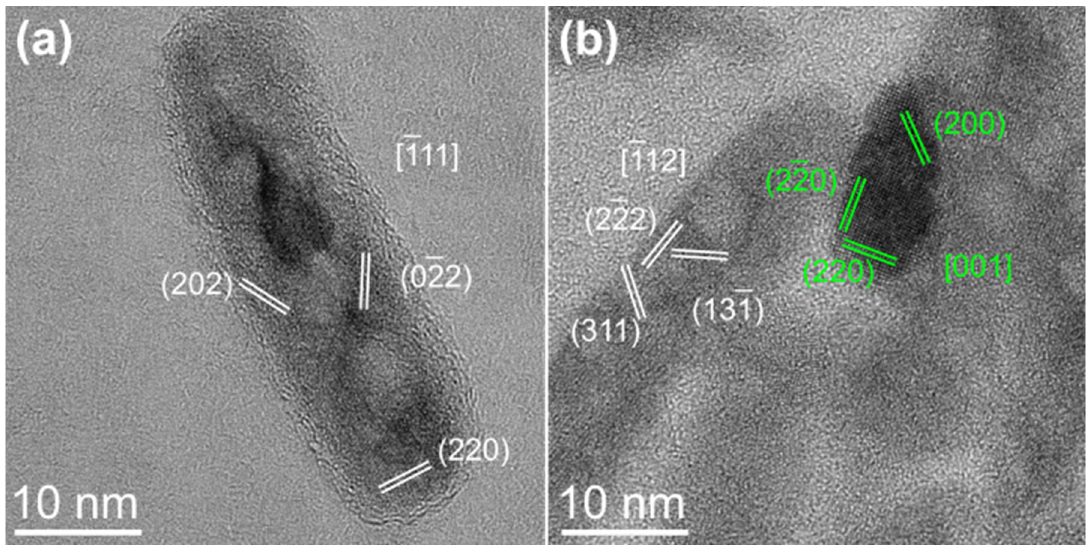
Figure 2. HRTEM imaging of: ( a ) S3 and ( b ) S3_Mn. Magnetite lattice planes are indicated in white, while those of hausmannite (Mn 3 O 4 ) are indicated in green.